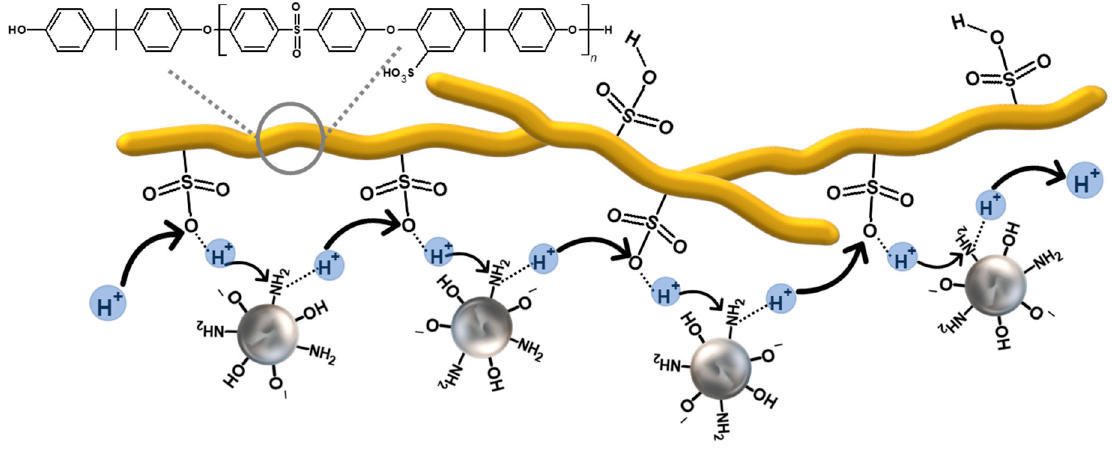
Figure 17. Proton transport in a Grotthuss mechanism proposed for sPEES membranes with modified silica with amino groups—through an acid–base interaction.